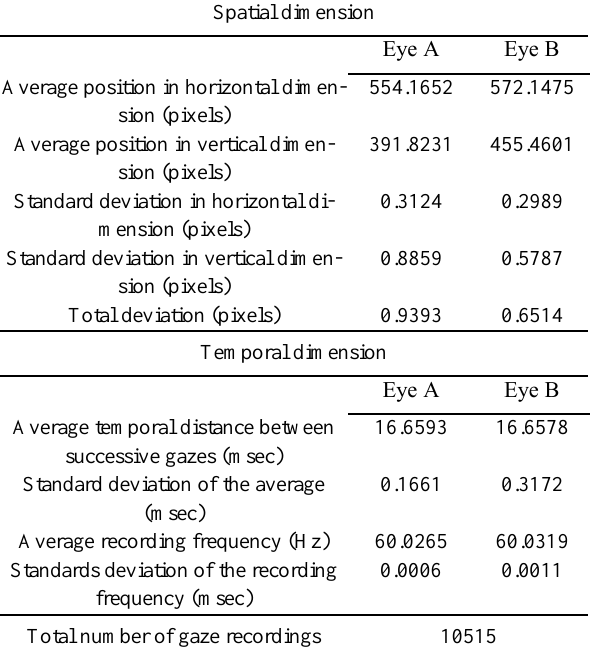
Adaptation of the eye tracking equipment in an artificial head with a pair of artificial eyes.